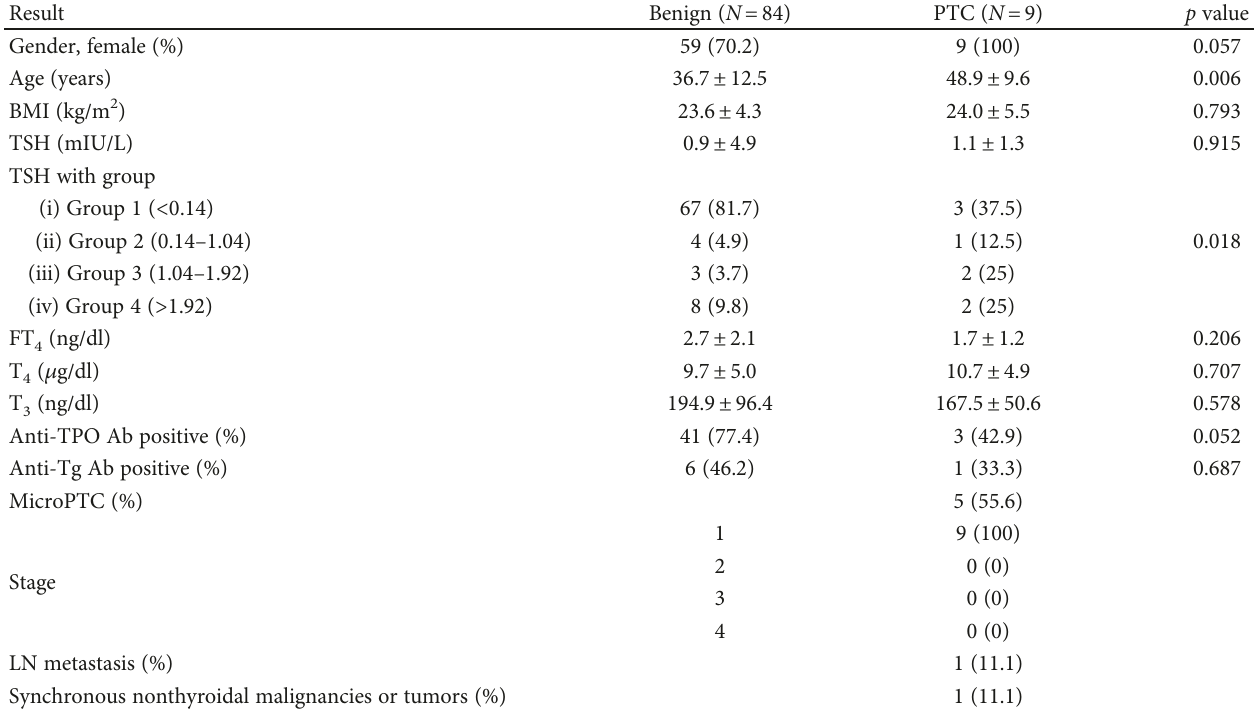
Table 6: Subgroup analysis of patients with positive TSH receptor